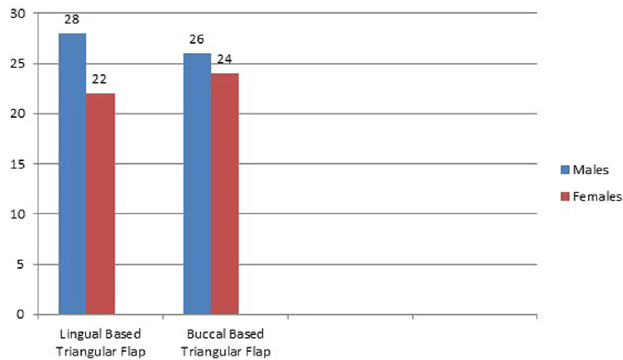
Fig. 5. Gender distribution between buccal based triangular fl ap and lingual based triangular